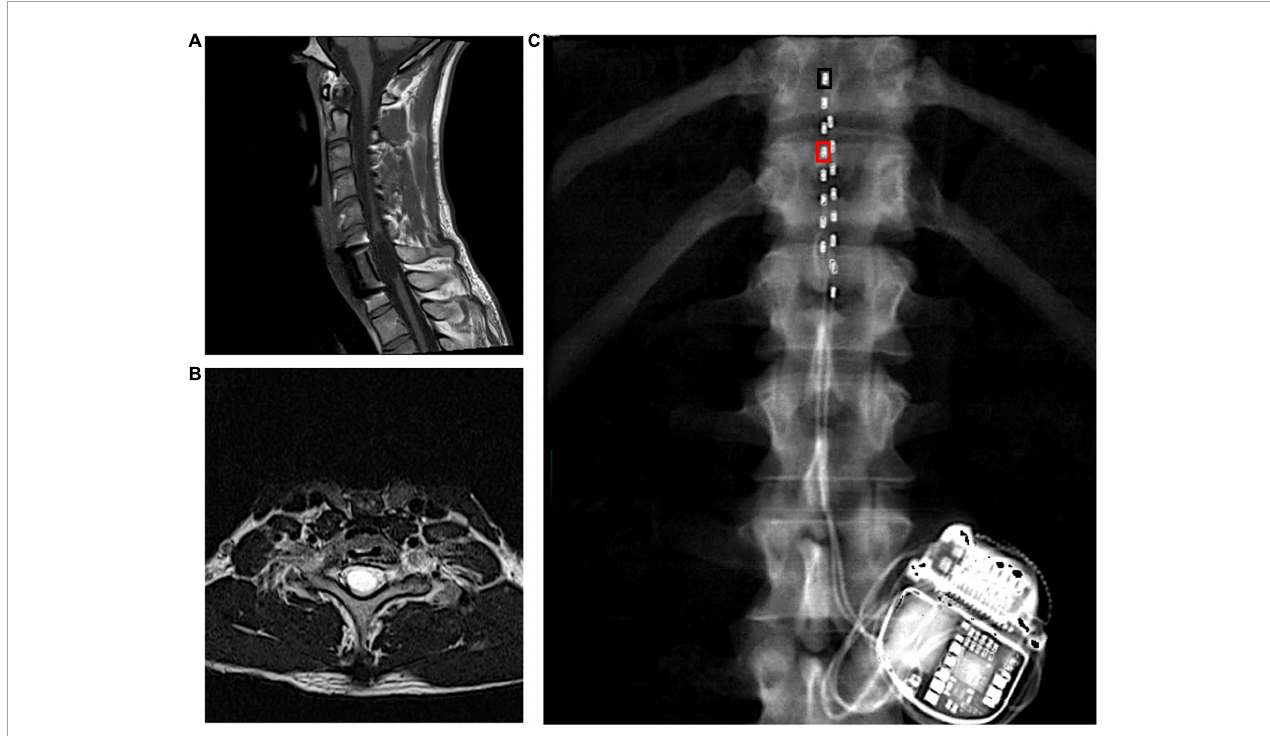
FIGURE1 (A) Longitudinal and (B) axial T2 MRIs highlighting the level of injury in a person with C8 complete motor and sensory SCI that were captured prior to implantation. (C) Leads placements with inter-pulse generator as captured by dual energy x-ray absorptiometry of the spine region. The black rectangle denotes the placement of the cathode at 0 and the right rectangle denotes the placement of the anode at 3. These configurations (–0 and +3) yielded rhythmic locomotor-like activity. The leads were staggered where the left lead covered the mid-line of T11 vertebral body to proximal border of L1 and the right lead extended from the T11/T12 inter-vertebral space to the mid-line of L1 vertebral body.